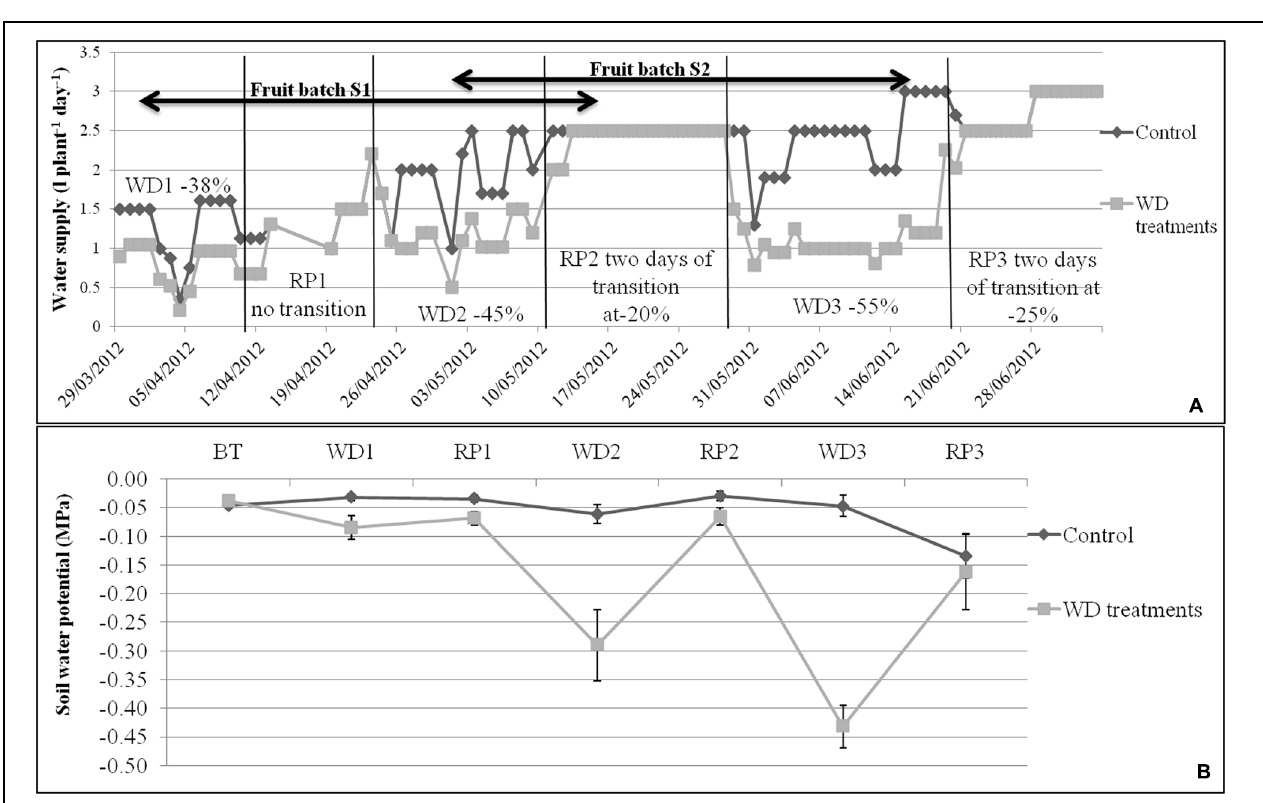
FIGURE 1 | (A) Water supply (water in l plant − 1 day − 1 ) for control and WD treatments, and (B) mean soil water potentials during each WD and RP period ( n = 8 ± SE), during the experiment period. Irrigation of control plants was monitored according to the measured potential evapotranspiration. The WD treatments consist in 3 cycles of WD of increasing intensity (–38, –45, and –55%) followed by RP periods. Transition periods of 2 days were applied after each WD period in order to reduce the risk of fruit blossom end rot. The fruit development periods of S1 and S2 lots are indicated by arrows.